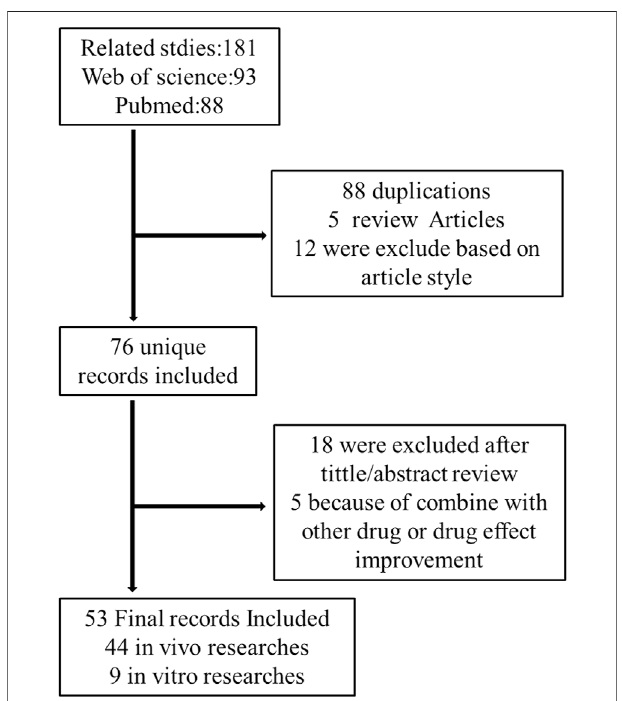
FIGURE 1 | Flow chart of the study